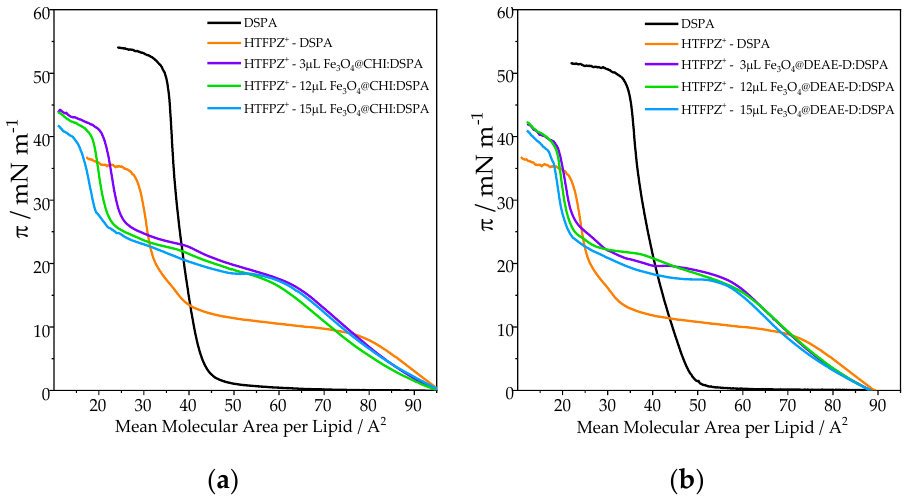
Figure 2. Surface pressure as a function of mean molecular area per lipid for the mixtures: ( a ) Fe 3 O 4 @CHI:DSPA (x µL: 50) and ( b ) Fe 3 O 4 @DEAE-D:DSPA (x µL: 50). Subphase composition: HTFPZ + 0.01 mM in LiCl 10 mM and LiCl 10 mM for black line.